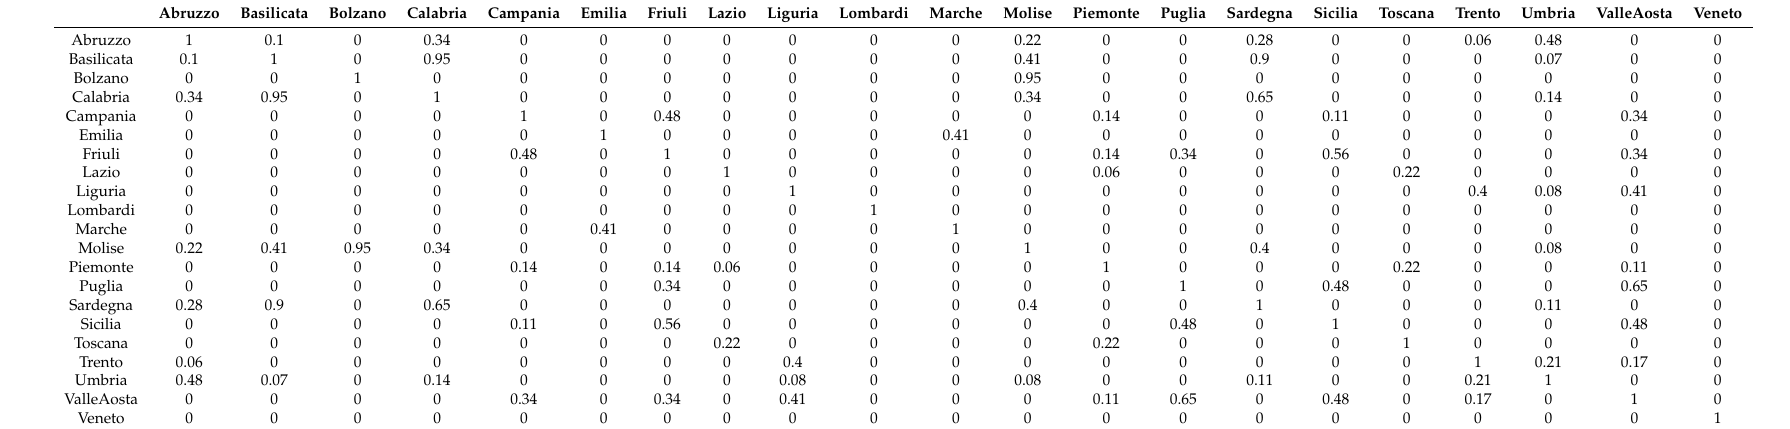
Table A57. Similarity values of Swabs network in the second week.